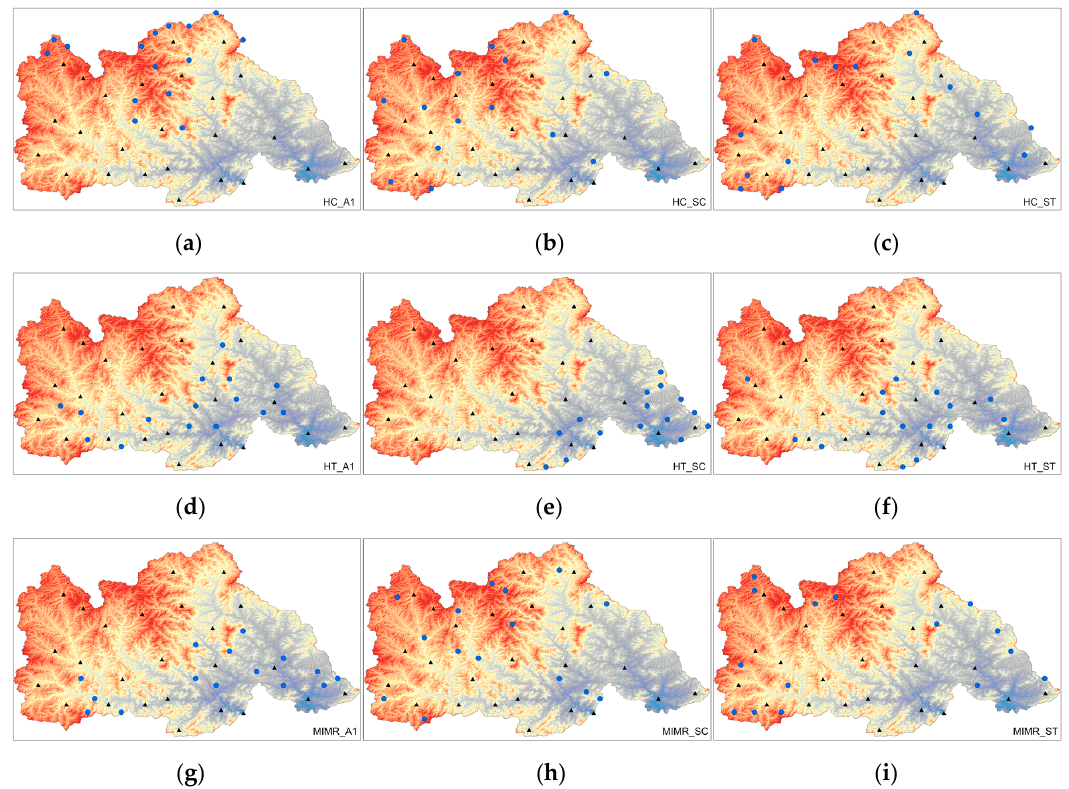
Figure 4. Optimization design results of a network with 40 rain gauges. The descriptions for ( a ) through ( i ) are the same as those in Figure 3.